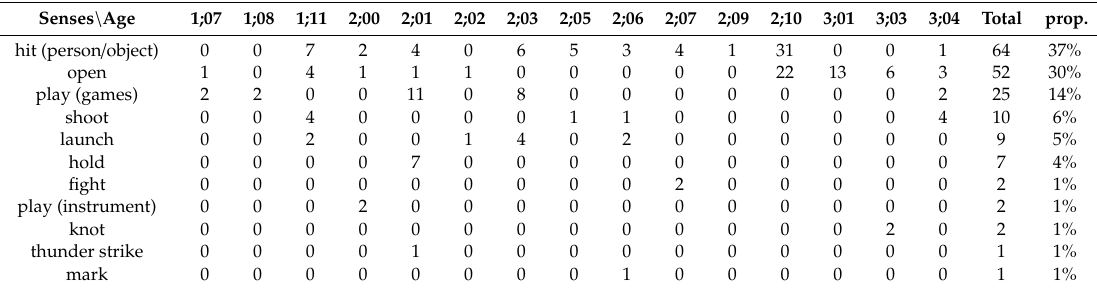
Table 4. Token frequencies of di ff erent senses of 打 dˇa in the child Tong’s speech by age. Senses \